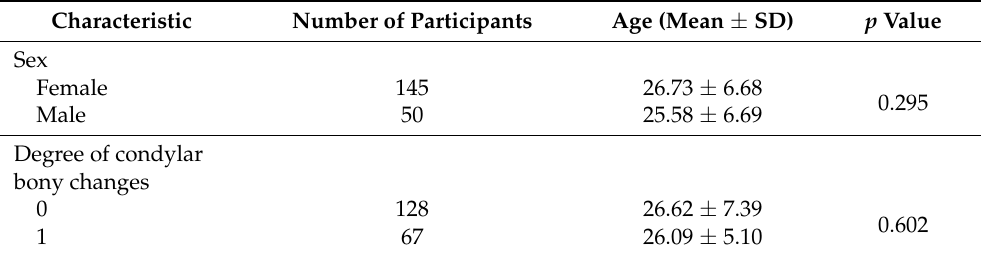
Table 2. Age characteristics of the